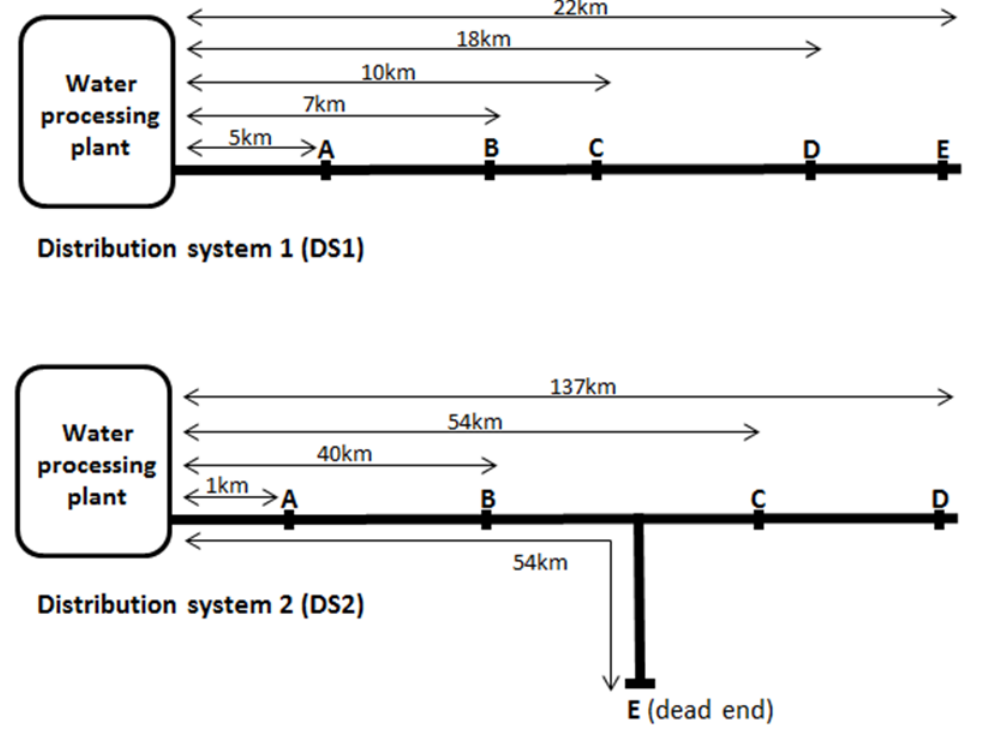
Figure 1. Schematic showing the sampling points in distribution system 1 (DS1) and distributions system 2 (DS2). Schematic is not too